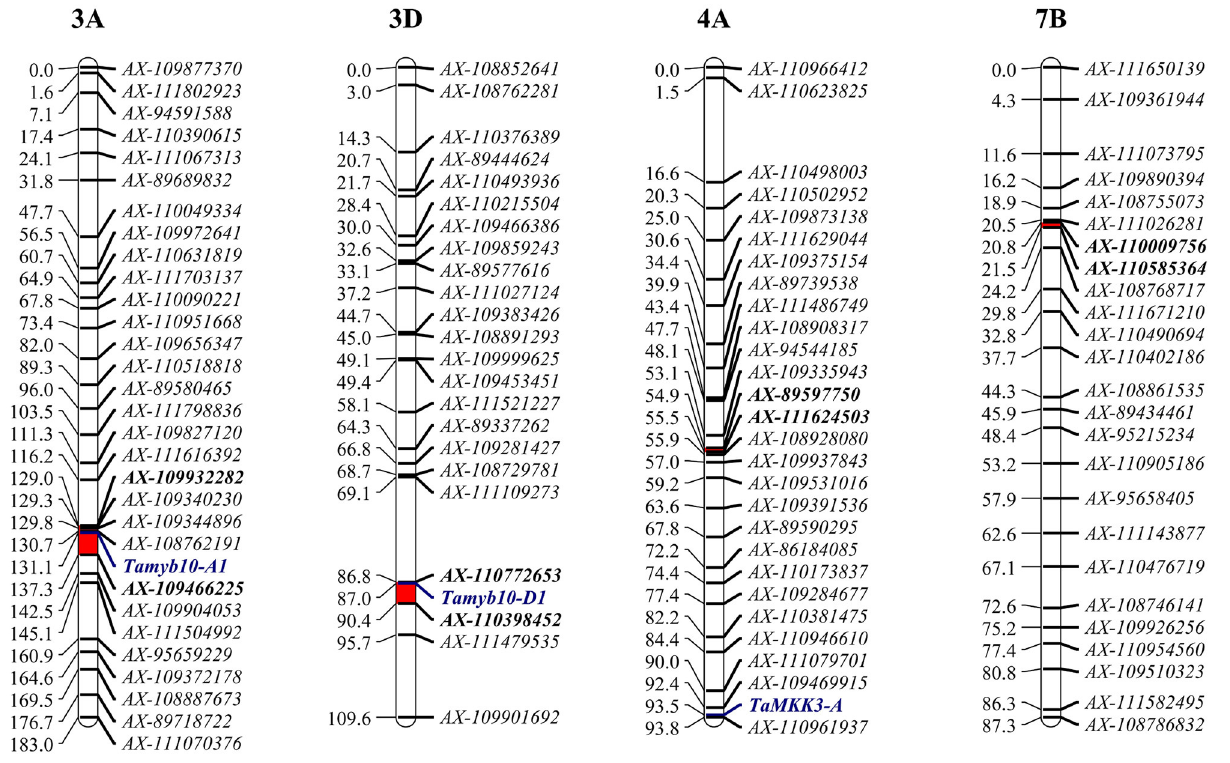
FIGURE 1 | Genetic mapping of Qphs.caas-3AL , Qphs.caas-3DL , Qphs.caas-4AL , and Qphs.caas-7BL in the Yangxiaomai/Zhongyou9507 recombinant inbred line (RIL) population. Target regions of the quantitative trait loci (QTL) are indicated as red bars; gene-specific markers are shown in blue script; and flanking markers are shown in